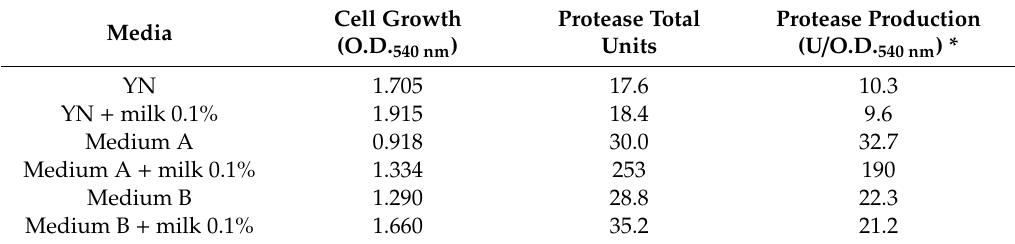
Table 2. E ff ect of di ff erent media on extracellular P. thermantarcticus protease production. Cell Growth Protease Total Media (O.D. 540 nm )